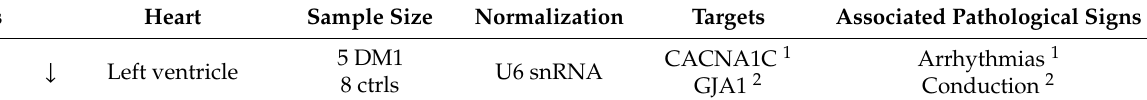
Table 2. Overview of the di ff erentially expressed miRNAs analyzed in heart